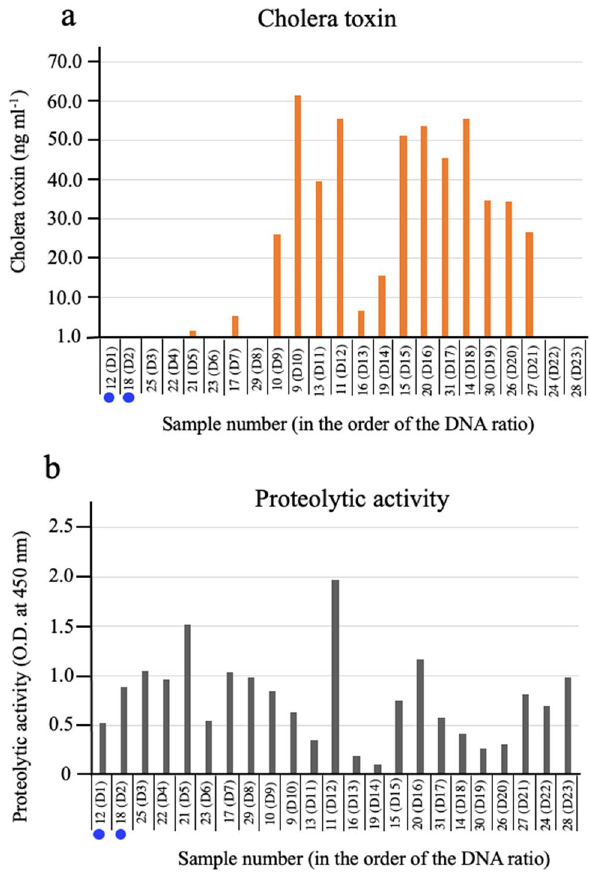
Figure 5. The levels of CT and proteolytic activity in the stool samples. Twenty-three stool samples of patients who were diagnosed with cholera disease were centrifuged at 10,000× g for 10 min. The CT content of the supernatants was determined using a GM1-ganglioside ELISA method 8 ( a ). The proteolytic activity of the supernatants was determined by the lysis of casein 10 ( b ). The sample numbers are the same as the numbers shown in the footnotes of Fig. 3. Numbers beginning with D in parentheses show the order of the content of DNA from V. cholerae among these samples. The samples in this figure are arranged in the order of the D numbers. A bar indicating the amount of CT is not drawn in the figure for the sample whose CT amount was below the detection limit. From the tests shown in Figs. 2, 3 and 4, samples of two patients who are unlikely to have diarrhea caused by the infection with V. cholerae are marked with a blue circle. O.D.: optical